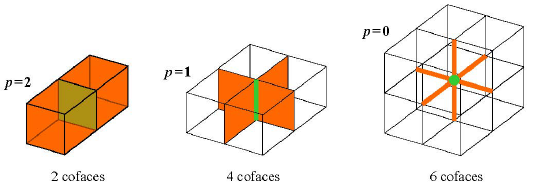
Figure 53: Cofaces of a p-cell of degree 0, 1 and 2.